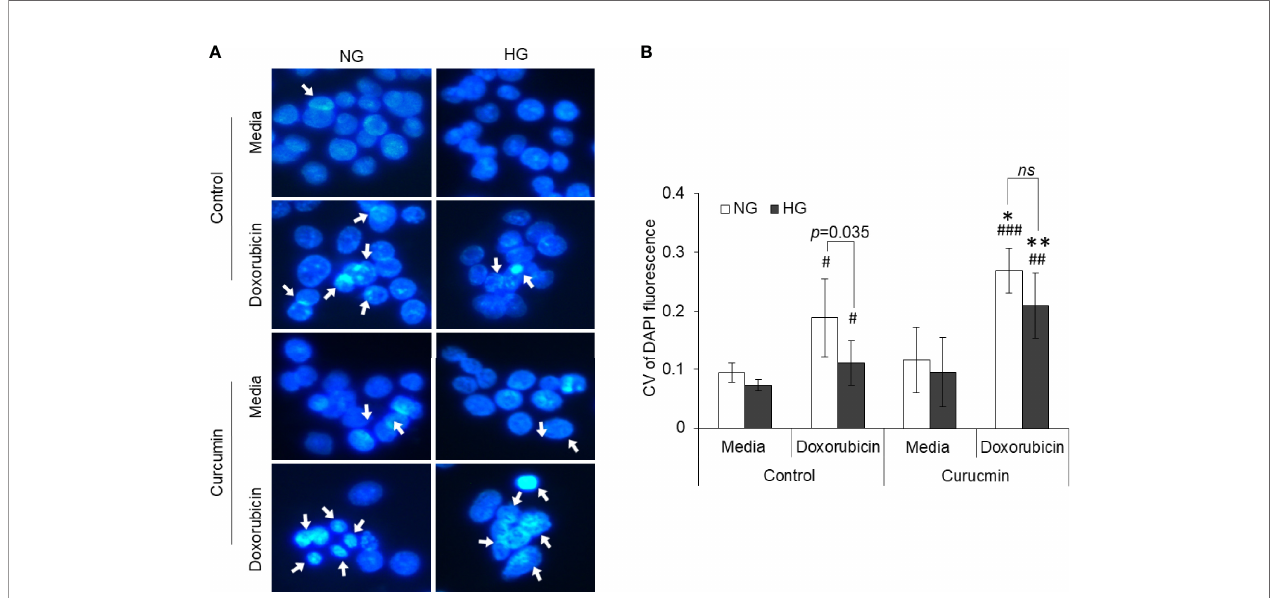
FIGURE 9 | Counteracting action of curcumin on inhibition of doxorubicin-induced chromatin condensation in HG medium. HepG2 cells treated doxorubicin, curcumin, or their combinations in NG or HG medium were processed for detection of chromatin condensation through DAPI staining. DAPI-stained cells were observed under fl uorescence microscope, and images were captured (A) . Arrowheads indicate chromatin condensation. To determine the chromatin compactness, DAPI-stained cells after Sobel edge detection transformation were analyzed with ImageJ software for all the pixels in each nucleus. Coef fi cient of variation was determined for all cells (B) . The values shown are Mean ± SD of three independent experiments conducted in triplicate. Photomicrographs shown are representative of three experiments conducted independently. * p < 0.05, ** p < 0.01 vs values of cells of control groups not treated with curcumin. # p < 0.05, ## p < 0.01, ### p < 0.001 vs values of cells incubated in medium without doxorubicin. ns, not signi fi